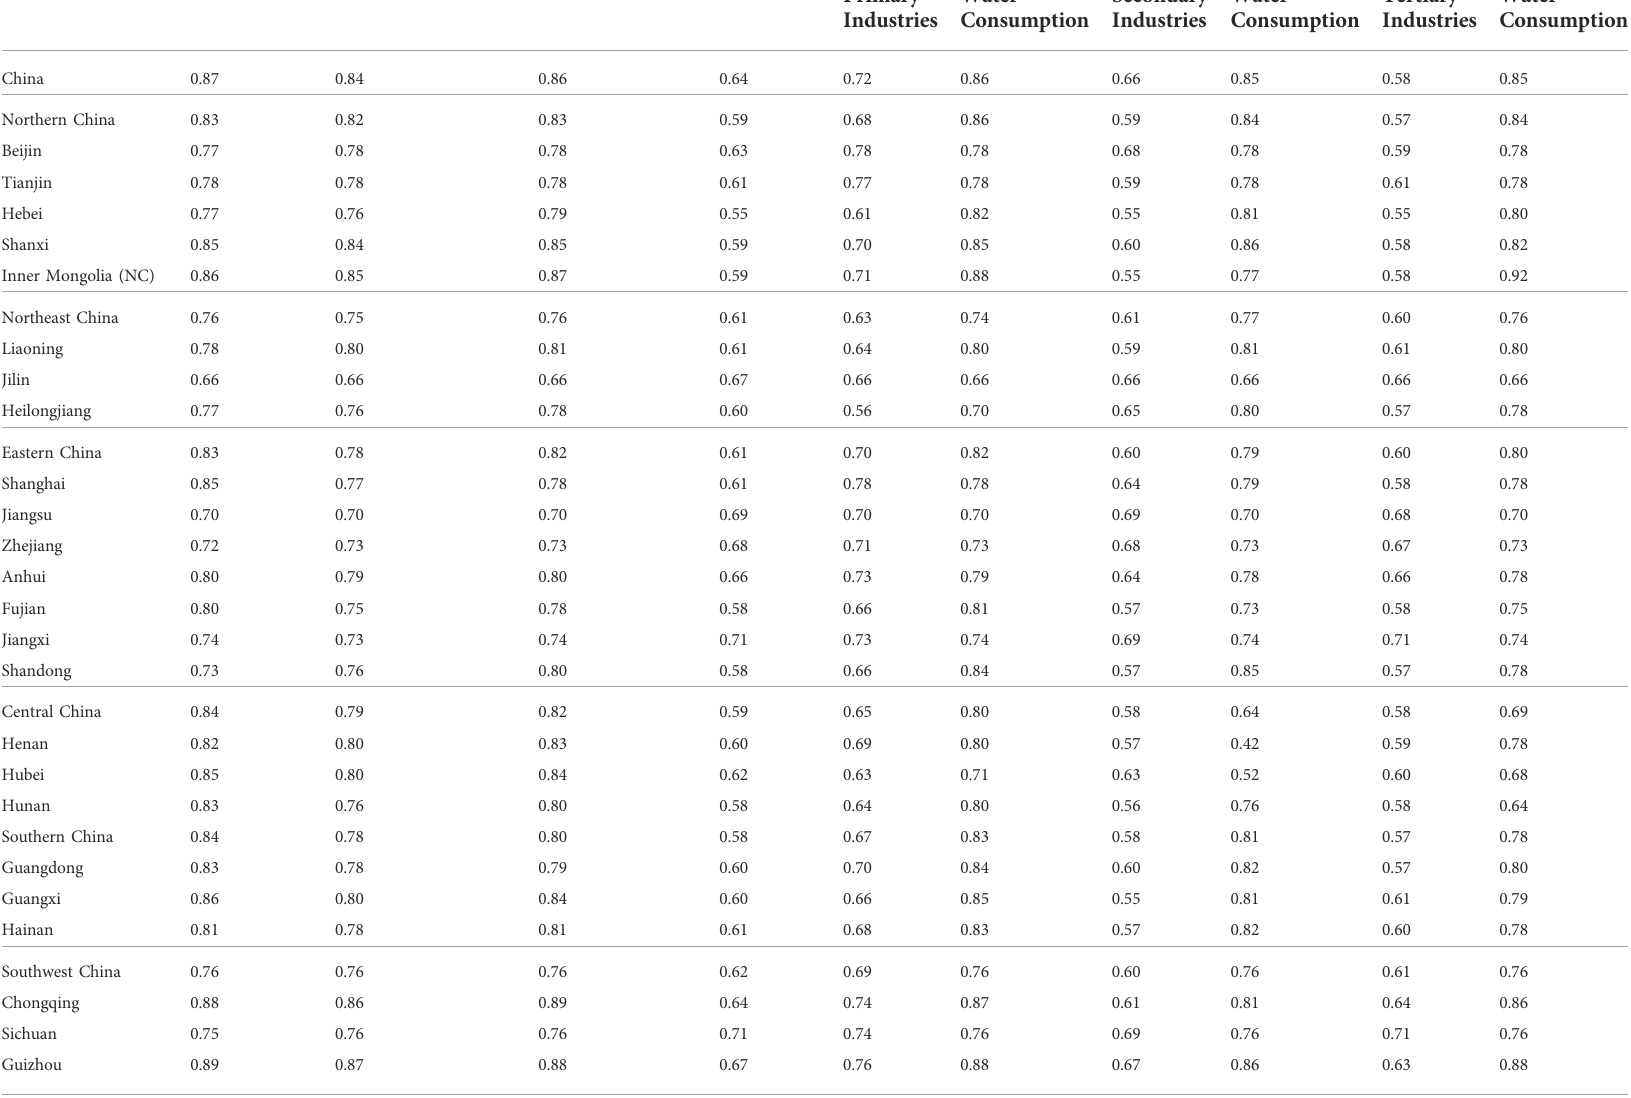
TABLE 1 GRC of GWS change and drivers at the national and regional scales in China. Study